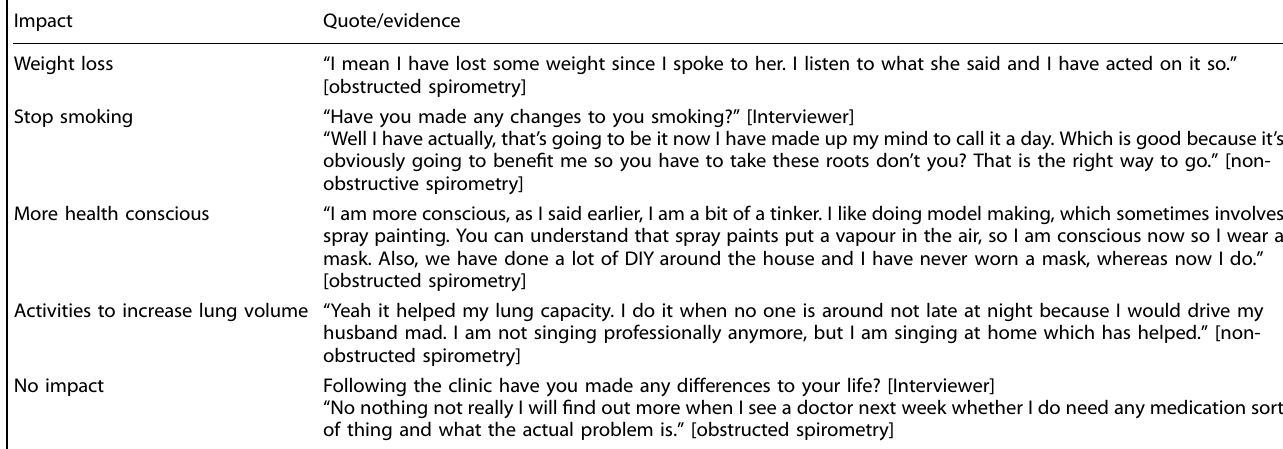
Table 2. Patients ’ perceived effect of clinic